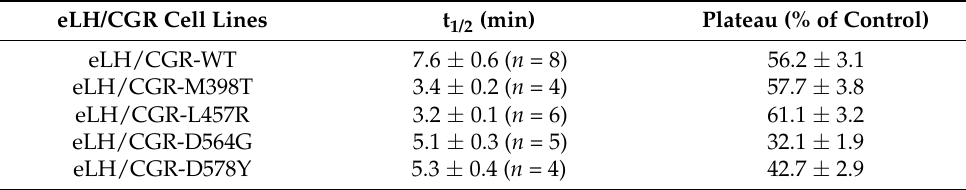
Table 3. Rates of cell-surface loss of receptors in transient transfected cell lines expressing the wild-type eLH/CGR and mutants